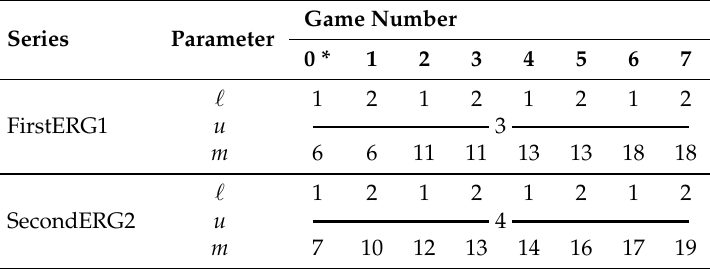
Table 1. The two extended race game (ERG) series implemented.